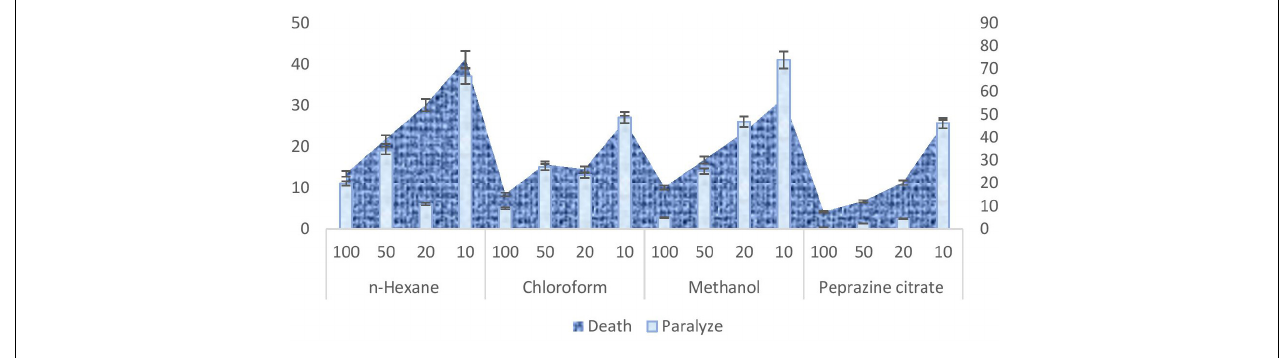
FIGURE 8 | Anthelmintic activity of Padina antillarum (Kützing) Piccone.